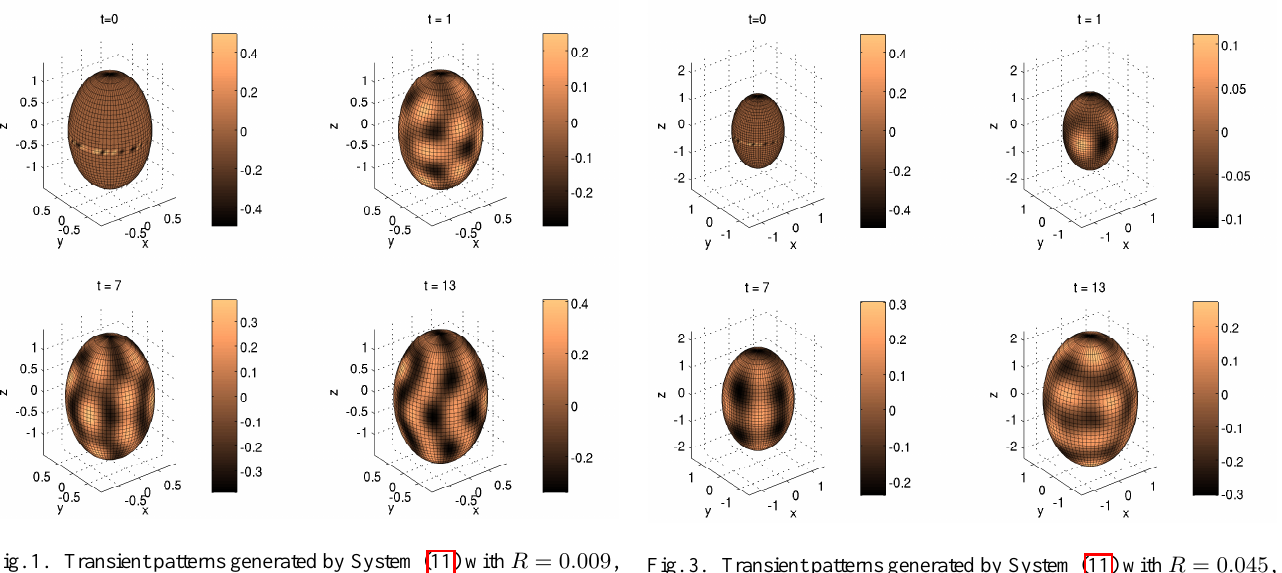
Fig. 1. Transient patterns generated by System (11) with R = 0 . 009 , ω = 150 .